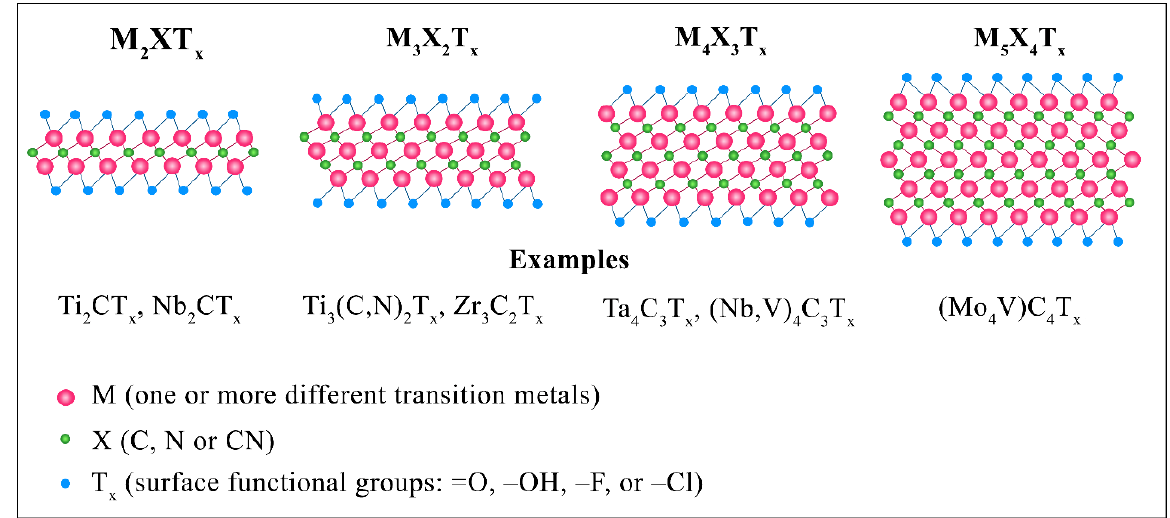
Figure 20. ( a ) SEM image of Ti 3 C 2 after removing the A layer; high-resolution STEM images of the MAX phase Ti 3 AlC 2 ( b ) and MXene Ti 3 C 2 Т х ( c ) along the [ highlighted in yellow, red, and green circles. Adapted from [62]. Reprinted with permission from [103] 2021 Elsevier.